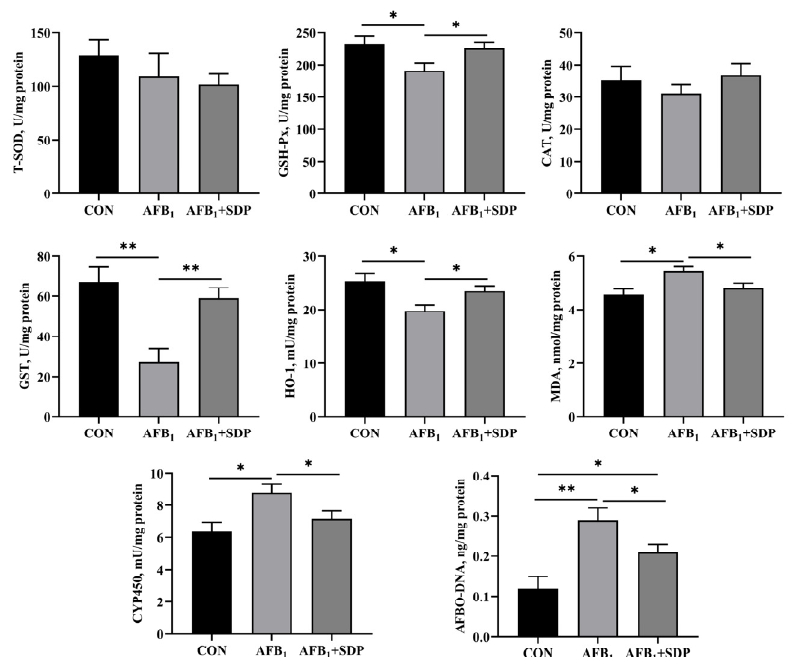
Figure 3. The protective effects of dietary seaweed ( Enteromorpha prolifera )-derived polysaccharides on enzymatic activity and AFBO-DNA level in liver of broiler chickens. * p < 0.05, ** p < 0.01, no superscript marks indicated that p > 0.10. CON: control group; AFB 1 group (fed diet with 0.1 mg/kg AFB 1 ); AFB 1 + SDP group (AFB 1 group + 0.25% SDP).